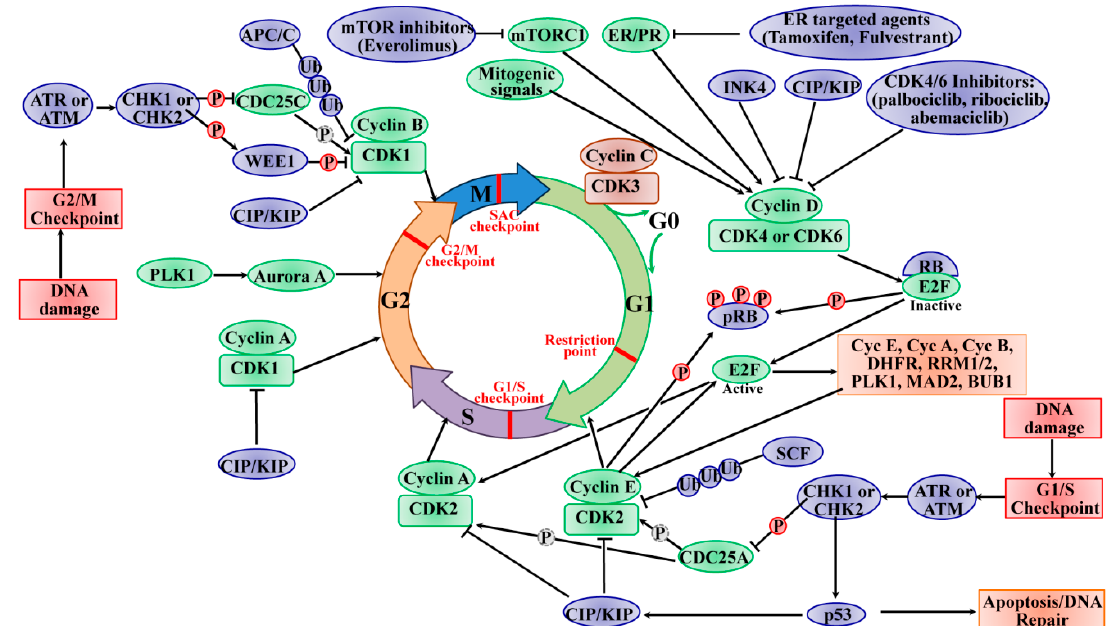
Figure 1. Progression of the cell cycle and its regulation by the CDKs and checkpoints. The cell cycle is regulated by many CDKs which form complexes with their associated cyclin partners. The cell cycle consists of four distinct ordered phases of the cell cycle, termed G0 / G1, S, G2, and M phases, and it contains multiple checkpoints (red) throughout to prevent genomic instability, as well as ensure faithful replication. The cells exit the cell cycle and enter the reversible or permanent quiescent state (G0 phase) regulated by cyclin C / CDK3. Various extracellular signals, such as the mitogenic signal, lead to the synthesis of cyclin D and stimulate CDK4 / 6, resulting in promoting entry into the cell cycle. Active CDK4 / 6 complexes initiate the phosphorylation (P) of RB protein, thereby unleashing E2F transcription factors, resulting in the expression of cyclin E, cyclin A, cyclin B, and many genes required for S phase progression. Cyclin E subsequently activates CDK2 and contributes to the further phosphorylating RB, progresses into S phase, and initiates DNA synthesis. Near the end of S phase, cyclin A removes cyclin E and forms a new complex, cyclin A / CDK2. Cyclin A / CDK2 terminates the S phase by phosphorylating CDC6 and E2F1; it drives the cell-cycle transition from S phase to G2 phase, and subsequently activates CDK1 by cyclin A, leading to cells entering the M phase. Upon mitosis, the CDK1 activity is maintained by the complex cyclin B / CDK1. The deregulation of CDK1 enables chromosome separation and the completion of mitosis and cytokinesis. The INK4, CIP / KIP, and CDK4 / 6 inhibitors (palbociclib, ribociclib, and abemaciclib) inhibit the activity of CDK / cyclin. The ubiquitination (Ub) of cyclins is involved in regulating the expression of many proteins to control the cyclical activities of the CDKs, such as SCF and APC / C. The PLK1 and aurora A proteins are involved in the progression through S phase and from G2 phase into M phase. In addition, DNA damage checkpoints safeguard the genomic integrity and trigger cell-cycle arrest via checkpoint kinase 2 (CHK2) and p53 in G1 phase or via CHK1 in S or G2 phase. P in a dashed circle shows dephosphorylation. Green ovals indicate positive regulators and blue ovals indicate negative regulators of cell-cycle progression. (Adapted from reference “[8], doi:10.1038 / nrc.2016.138” with permission of the journal Nature Reviews Cancer